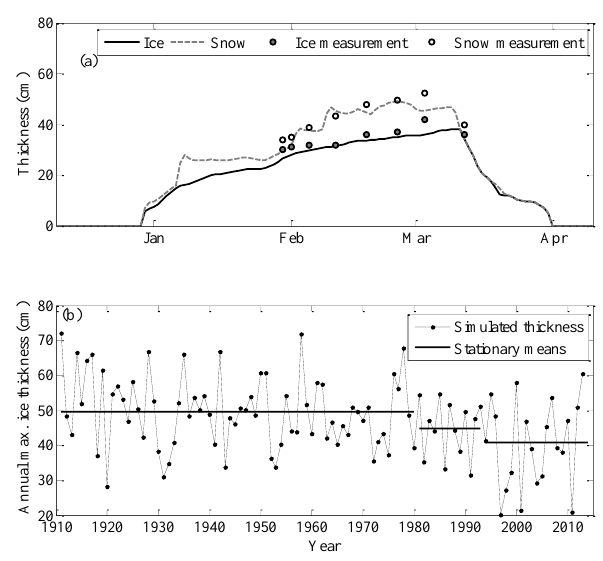
Figure 3. (a) Simulated ice and snow with measured values for the winter 2009–2010 and (b) simulated annual maximum total ice